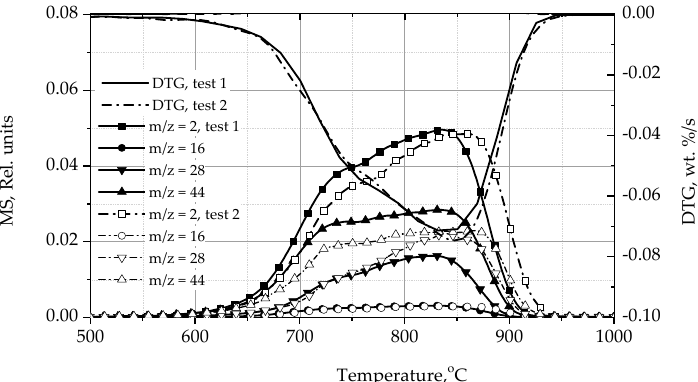
Figure 2. Mass spectrometry (MS) and DTG plots for the steam gasification products of the RPC char (17 mol % H 2 O in Ar).